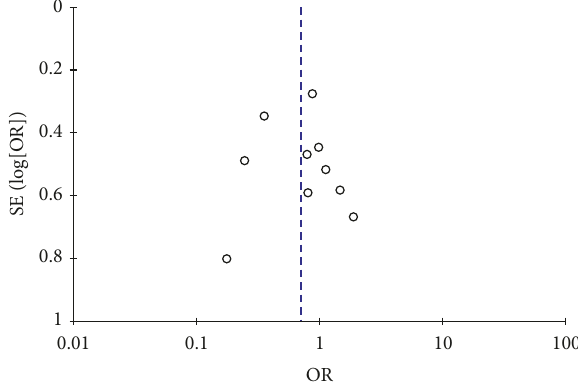
Figure 5: Funnel plot of comparison: postoperative pancreatic